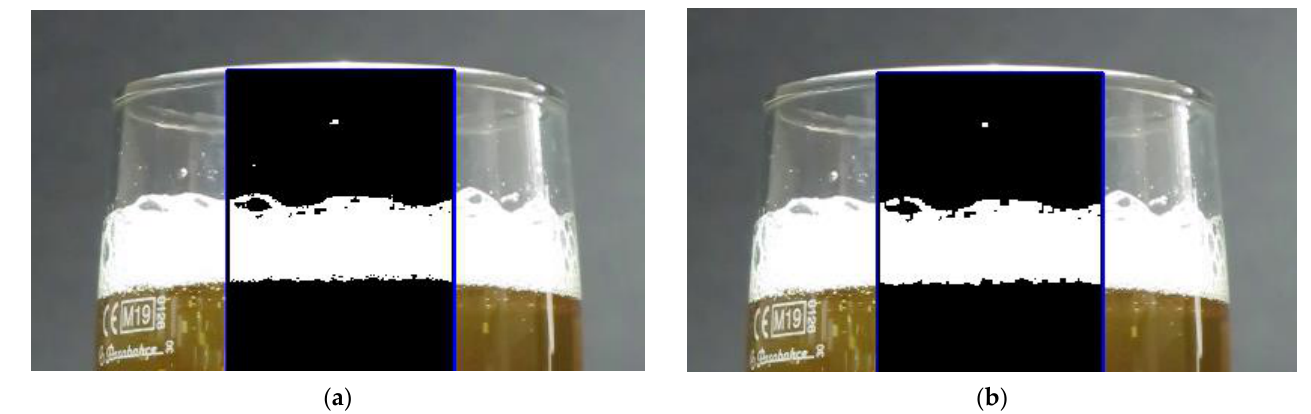
Figure 3. Magnified images of Figure 2a,b: ( a ) Initial binary image of ROI thresholded in HSV color space with visible artifacts; ( b ) Final binary image of ROI thresholded in HSV color space with artifacts removed after performing morphological operations.